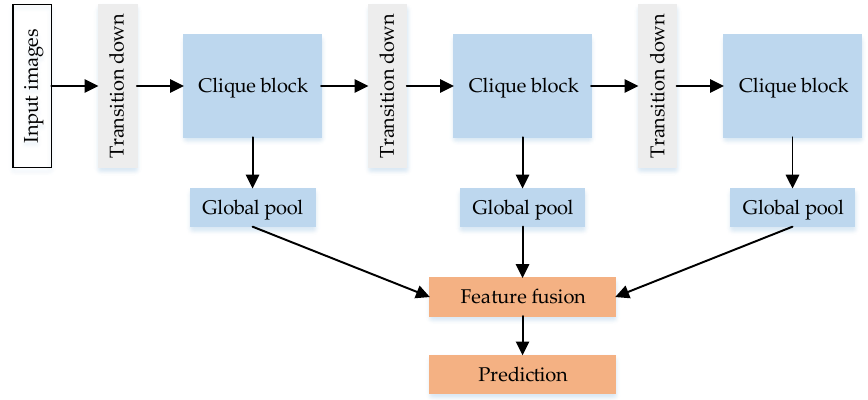
Figure 3. The original CliqueNet architecture.